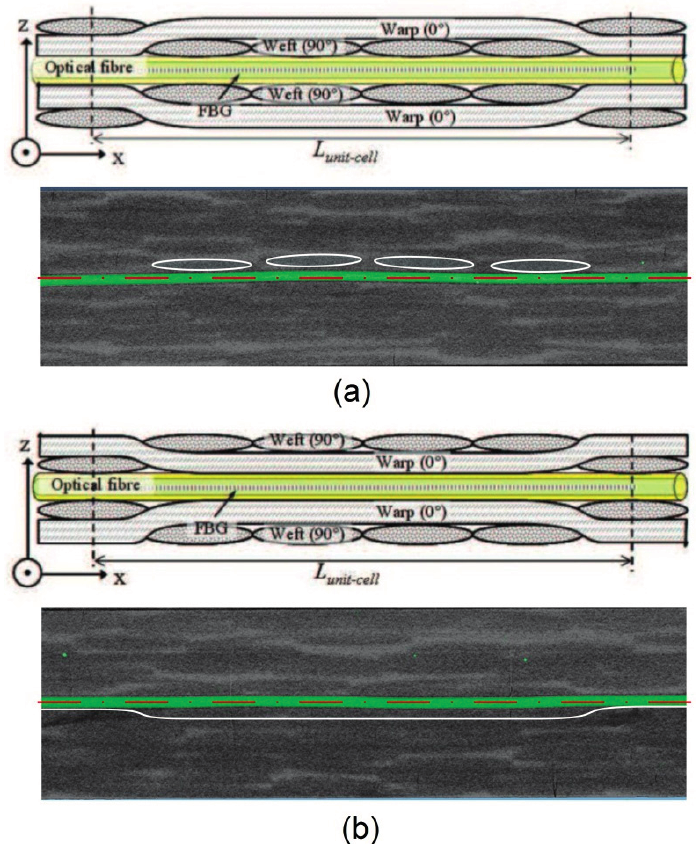
Figure 8. ( a ) Schematic and micro-CT side section of a 125 µm optical fibre embedded in a symmetrical stacked carbon-PPS [(0,90)] 4s layup; ( b ) Same schematic and micro-CT side section obtained for a [(90,0)] 4s layup. The Optical fibre has been highlighted in green colour. One can notice the bending of the fibre with respect to its axis (horizontal dash-dotted red line). The axis has been obtained from the envelope cylinder defined around the fibre. Finally, the white lines represent the envelopes of the bundle yarns of carbon